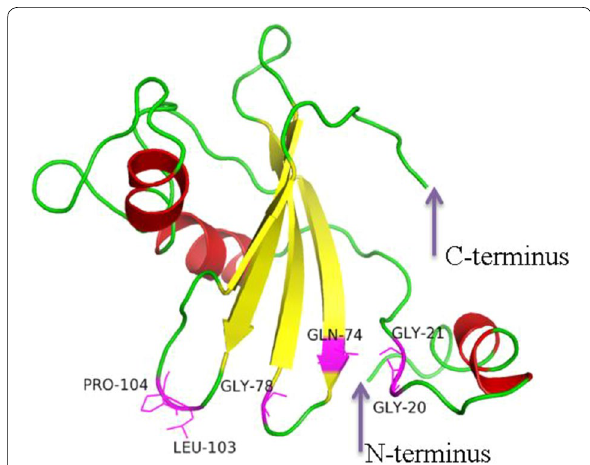
Fig. 5 Three-dimensional structure of TK-cystatin. Its 3D structure showed the typical wedge-shaped structure of cysteine protease inhibitor. The deep purple arrows pointed to the N- terminus or C-terminus of TK-cystatin. The position of the conserved motif in the 3D structure was shown by a magenta stick, next to the